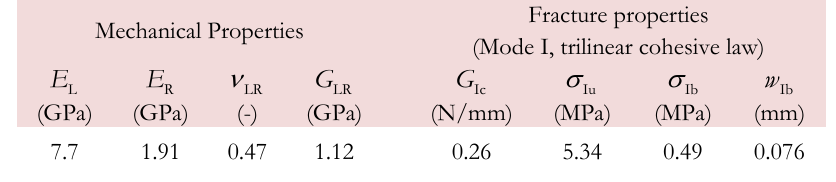
F INITE ELEMENT